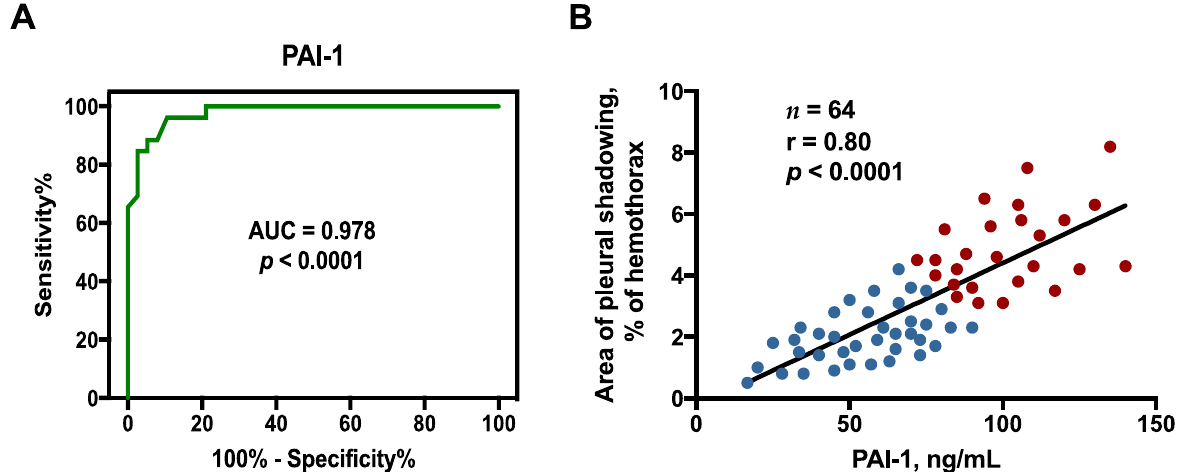
Figure 1. Correlation between pleural fluid PAI-1 level and residual pleural fibrosis among GPB PPE patients: ( A ) ROC curve for PAI-1 value to predict RPT > 10 mm; ( B ) Correlation between PAI-1 and residual pleural opacity CXR score. ROC, receiver operating characteristic; AUC, area under the ROC curve; GPB, Gram-positive bacteria; PPE, parapneumonic pleural effusion. Blue dot, GPB PPE with RPT ≤ 10 mm ( n = 38); Red dot, GPB PPE with RPT > 10 mm ( n = 26).